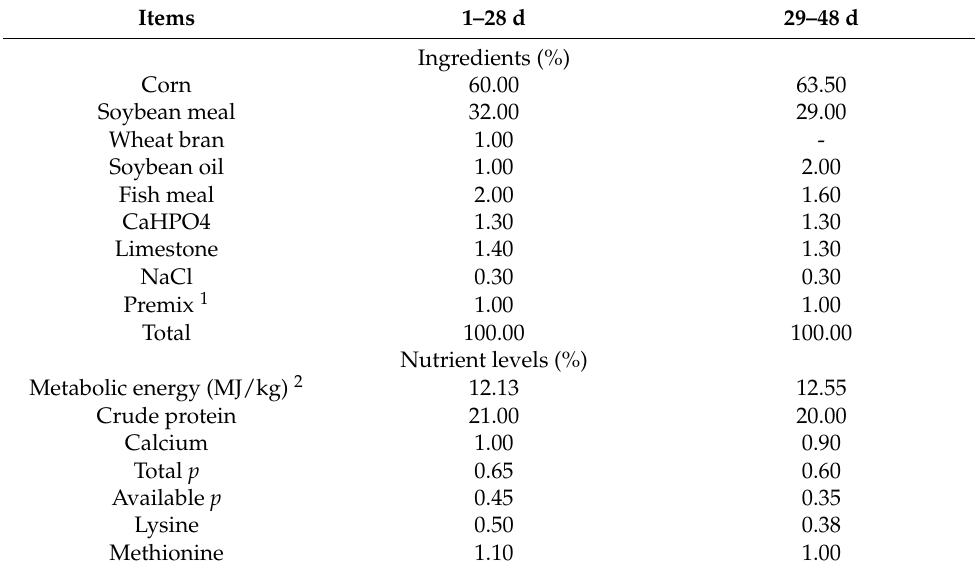
Table 1. Ingredient and nutrient levels of the basal diet in each feeding phase for